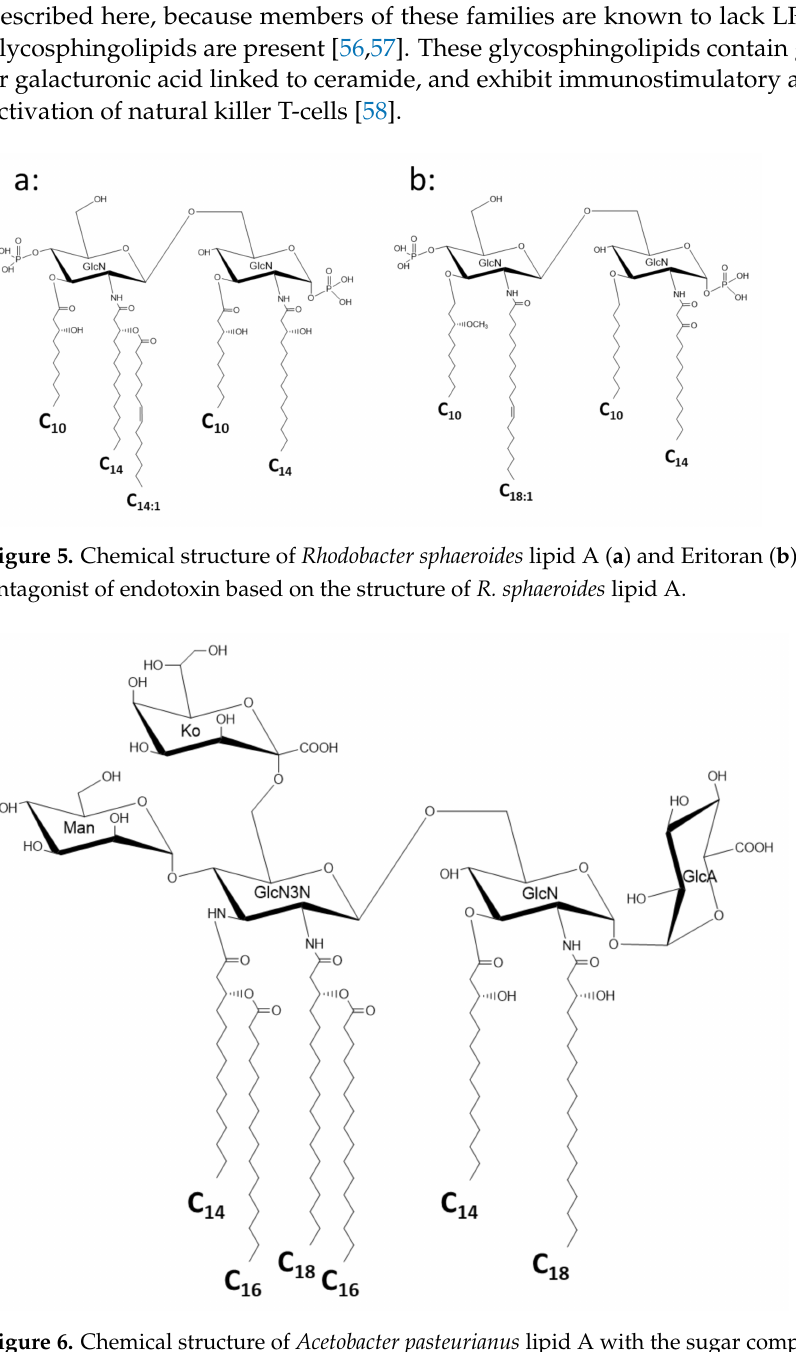
Figure 6. Chemical structure of Acetobacter pasteurianus lipid A with the sugar component (Ko) of the core oligosaccharide at the 6 (cid:48) position of the